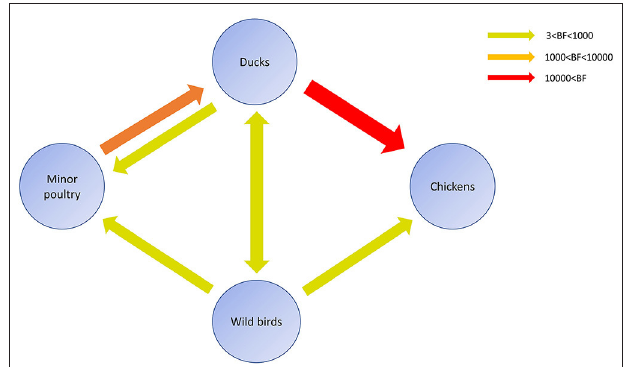
FIGURE 6 | Inferred transmission networks of H5N8 viruses between host species. Arrows show the directions of viral transmission. Line colors indicate the overall Bayes Factor test support for epidemiological linkage. Red, orange, and green lines indicate statistical support with BF > 10,000 (very strong support), 1,000 < BF < 10,000 (strong support), and 3 < BF < 1,000, respectively.